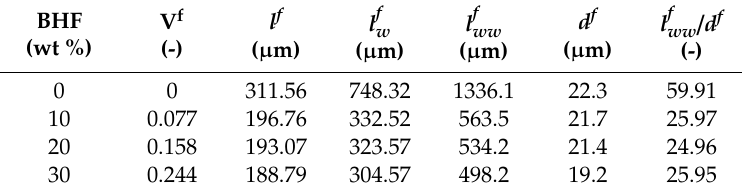
Table 2. Morphology of BHF prior to be incorporated to PA6 and after being incorporated at di ff erent reinforcement contents.